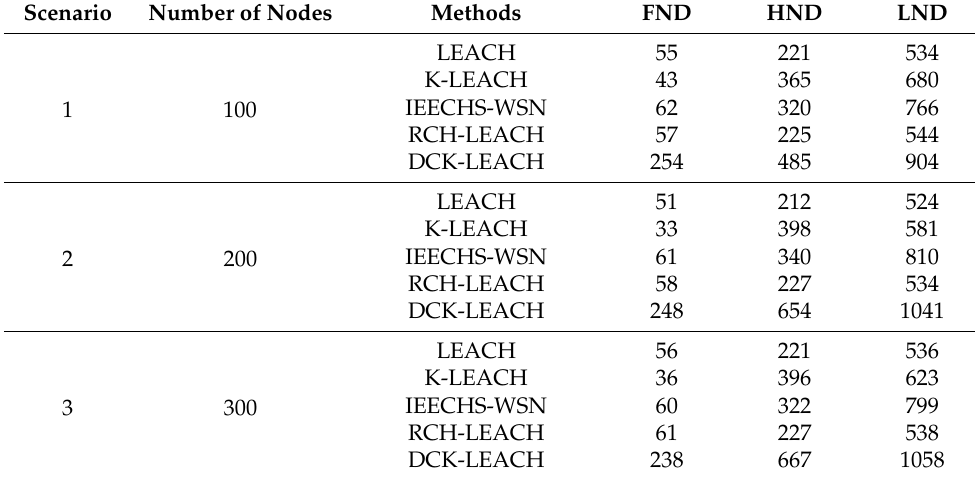
Table 3. Comparison FND, HND, LND of LEACH, K-LEACH, IEECHS-WSN, RCH-LEACH, and